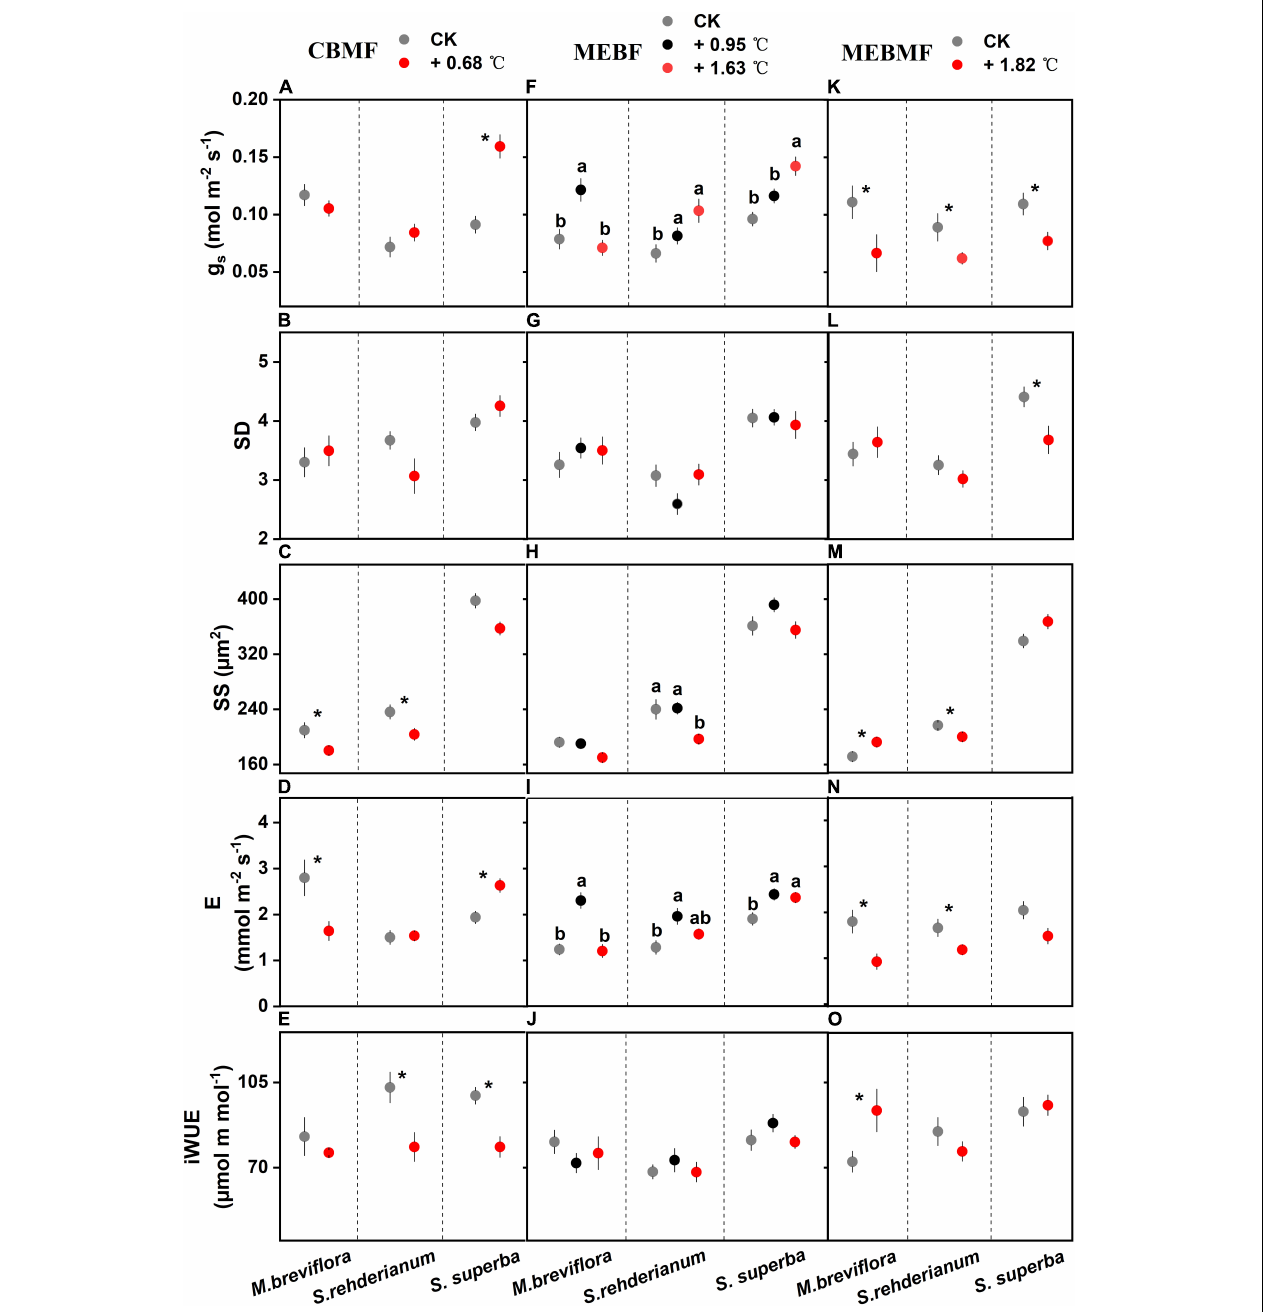
FIGURE 3 | (A,F,K) Stomatal conductance (g s , mol m − 2 s − 1 , n = 12), (B,G,L) stomatal density (SD, 10 − 4 , n = 15), (C,H,M) stomatal size (SS, µ m 2 , n = 50), (D,I,N) transpiration rate (E, mmol m − 2 s − 1 , n = 12) and (E,J,O) instantaneous water use efficiency (iWUE, µ mol m mol − 1 , n = 12) of Machilus breviflora , Syzygium rehderianum and Schima superba exposed to various warming treatments in coniferous and broadleaf mixed forest (CBMF), mountain evergreen broadleaf forest (MEBF) and monsoon evergreen broadleaf forest (MEBMF). Different lowercase letters above the error bars (standard errors) indicate significant differences in g s , SD, SS, E and iWUE from August 2018 or 2019 to August 2020.